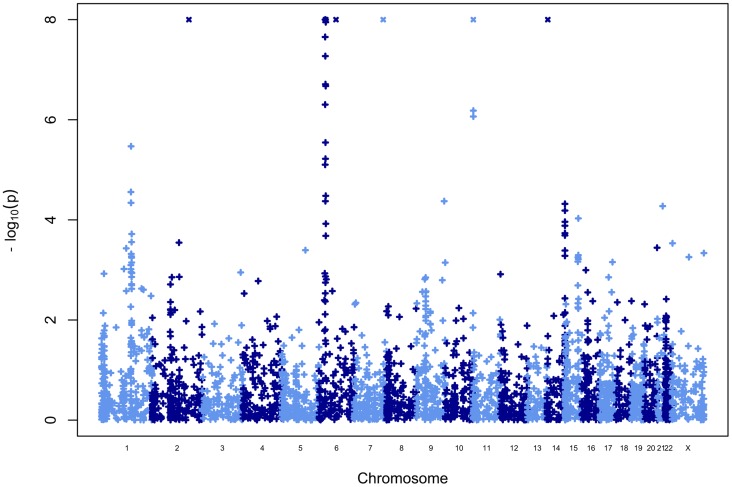
Manhattan plot for the FBAT-CNV P-values.The y-axis shows the distribution of –log10(p) where p is the FBAT-CNV test association test P-value for all CNV loci passing quality control filters (Methods). The x-axis shows chromosomes numbered from 1 (left) to X (right).